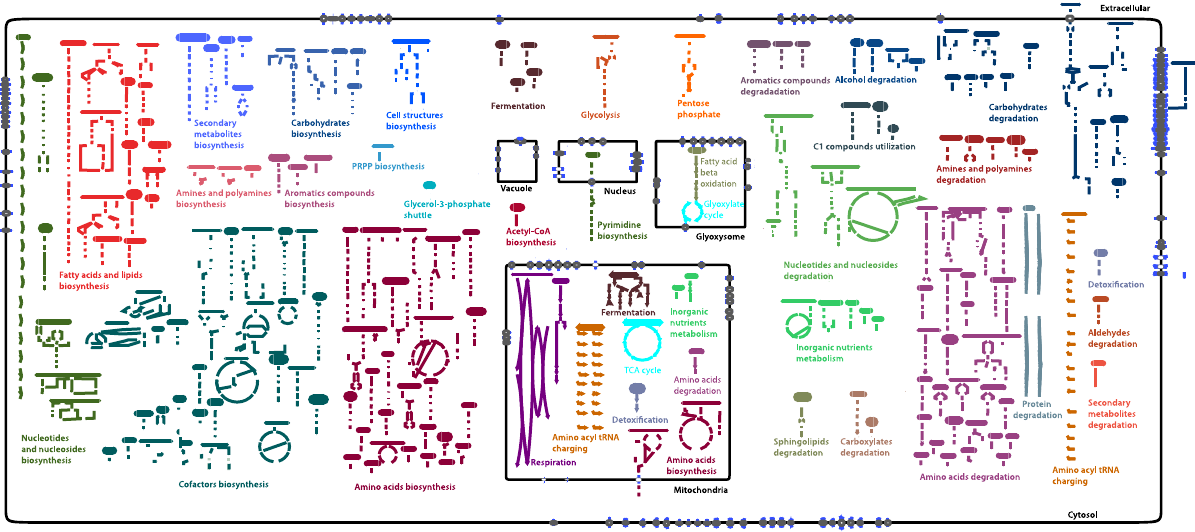
Figure 3. Metabolic overview of Neurospora crassa. The 257 metabolic pathways of Neurospora are divided into the 35 color-coded pathway classes. Biosynthetic pathways are displayed on the left, energy metabolism in the center, and degradation pathways are on the right. In addition to the cytosol and extracellular space, the model also contains 4 organelles: these are the vacuole, the nucleus, and the mitochondrion. The 299 transport reactions enable uptake and excretion of 137 metabolites and also exchange between the cytosol and each organelle.